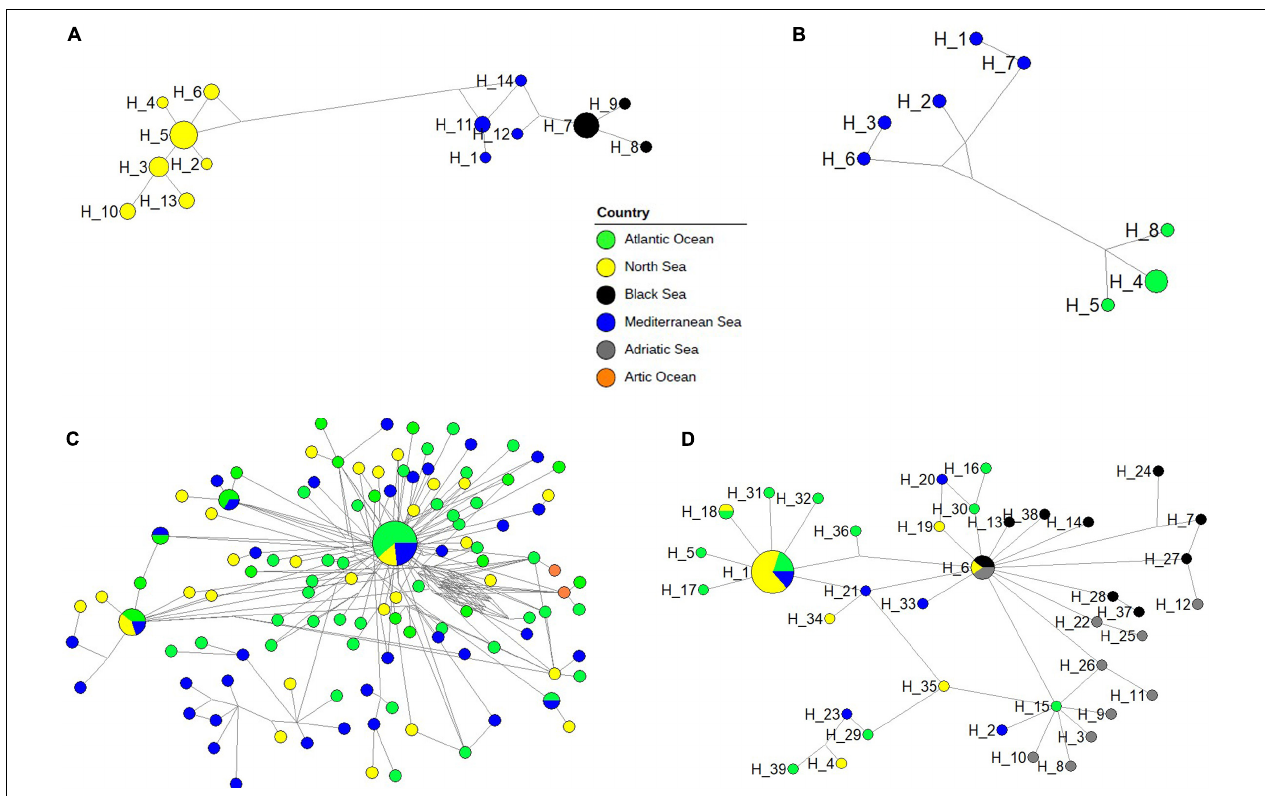
FIGURE 7 | Phylogenetic networks of four species including all intraspecies specimens: (A) Acartia clausi ; (B) Temora stylifera ; (C) Centropages typicus ; (D) Calanus helgolandicus / C. euxinus . Each circle represents a single haplotype and its diameter is proportional to the number of individuals carrying the haplotypes, the smallest circles representing a single individual. The length of connecting lines is proportional to the number of base substitutions between two